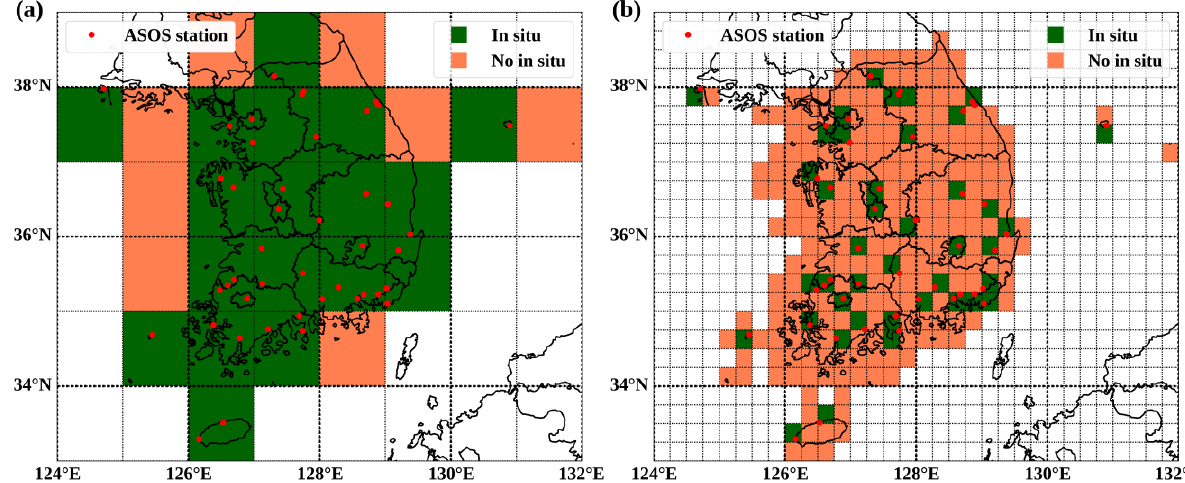
Figure 15. The distribution of SSI observing grid points with ( a ) minimum resolution of 100 km and ( b ) ideal resolution of 25 km from the World Meteorological Organization (WMO), where red circles indicate the ASOS stations operated by the KMA, and coral and green rectangles represent the missed and observed grid points,